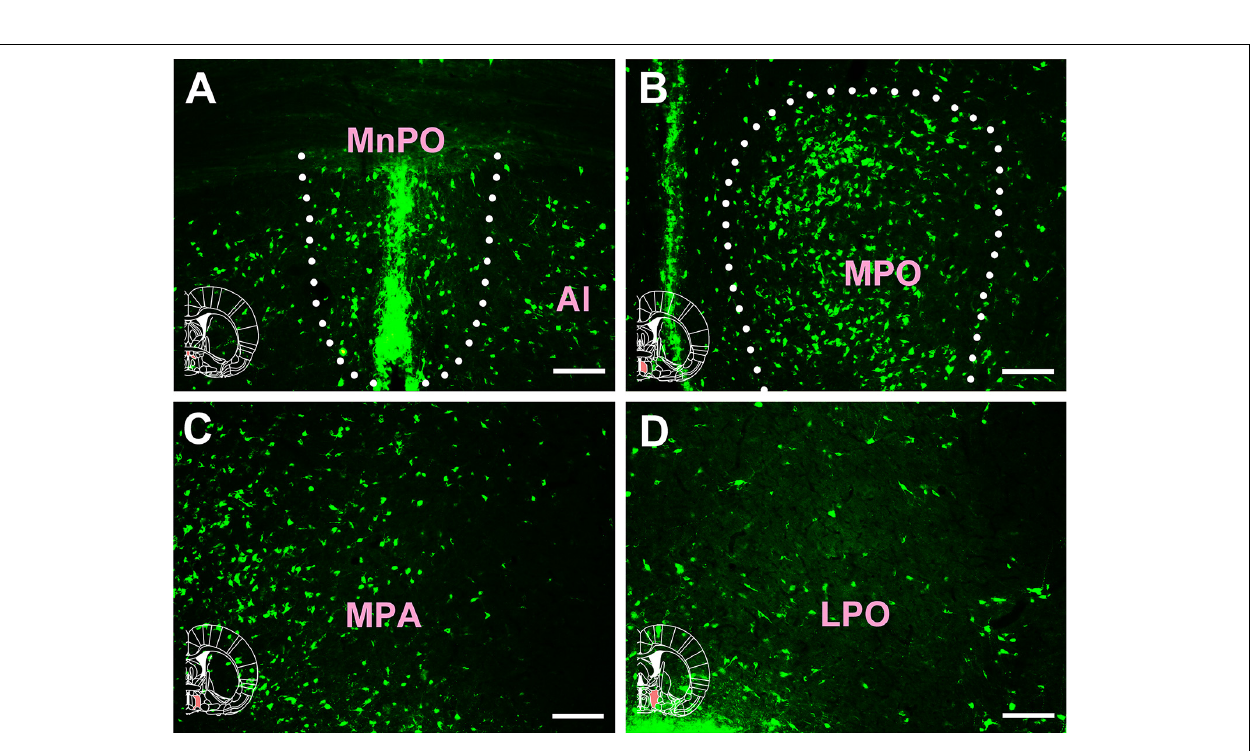
FIGURE 6 | Distribution of cholera toxin subunit B-positive neurons in the preoptic area Part I. (A–D) The positive neurons in MnPO, Al, MPO, MPA, and LPO (MnPO, median preoptic nucleus; Al, alar nucleus; MPO, medial preoptic nucleus; MPA, medial preoptic area; LPO, lateral preoptic area). Bar = 100 µ m.